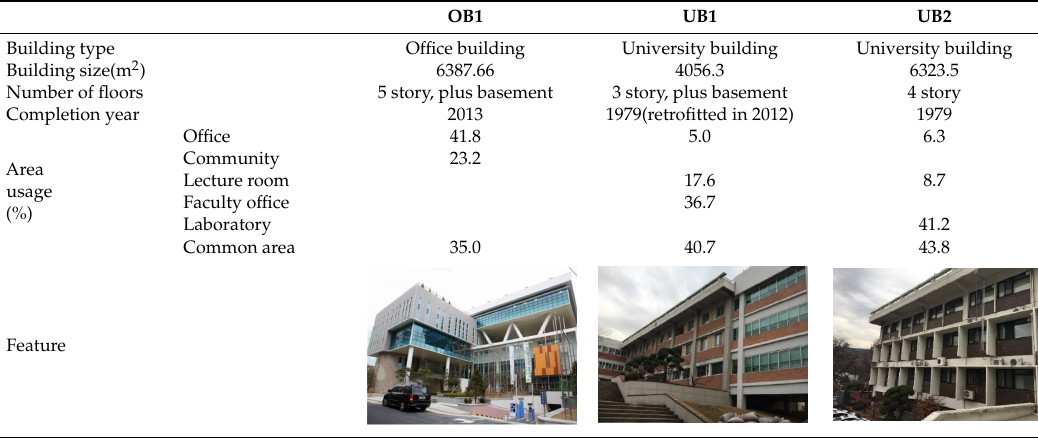
Table 4. Description of the buildings studied.